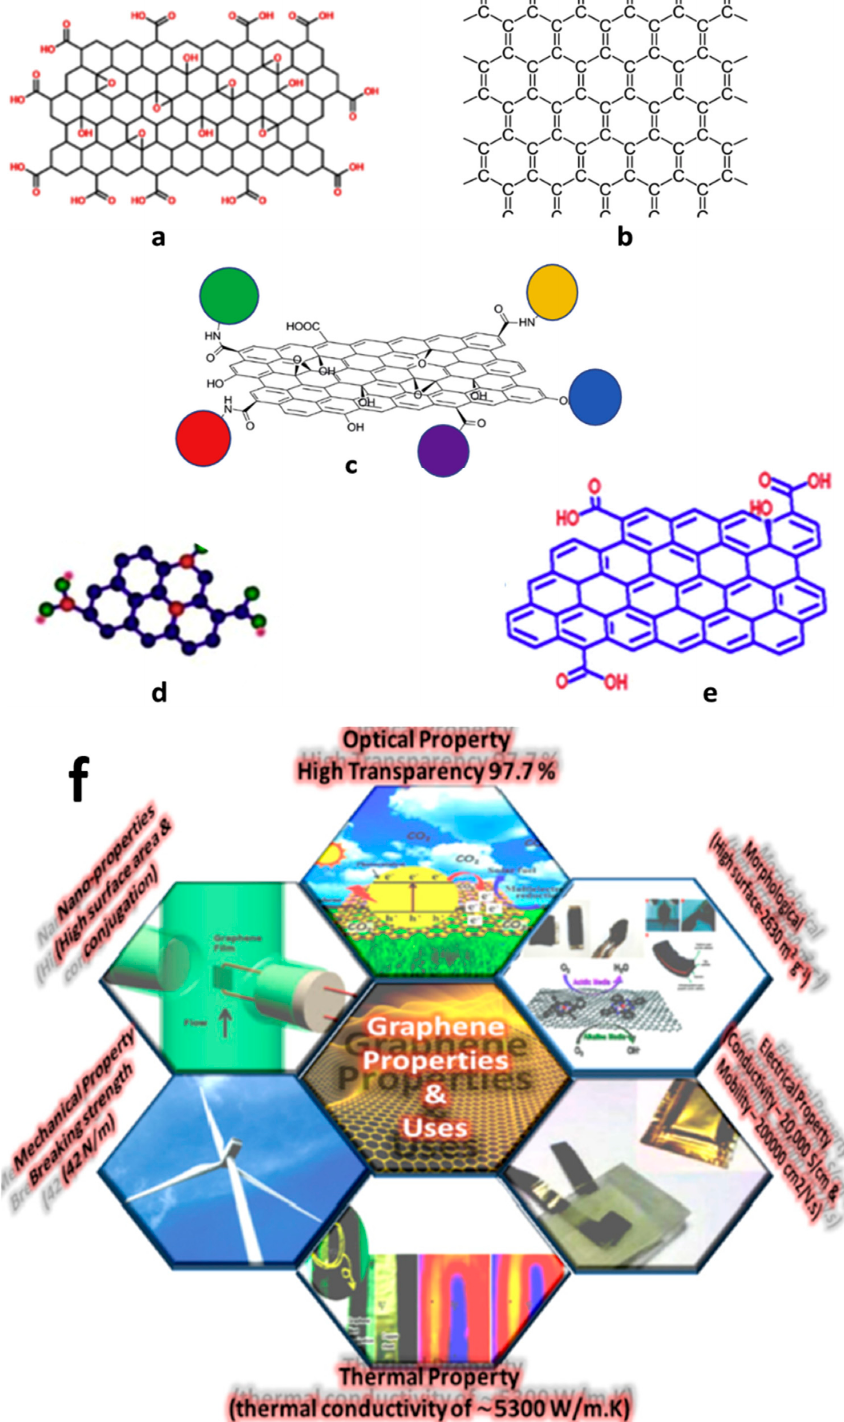
Figure 3. Some common forms of graphene: ( a ) graphene oxide, ( b ) pristine graphene, ( c ) functionalized graphene, ( d ) graphene quantum dot and ( e ) reduced graphene oxide. Reproduced with permission from Reference [46]. Licensed under a Creative Commons Attribution 3.0 International License (https://creativecommons.org/licenses/by/3.0/); ( f ) Different properties of graphene and its applications. Reproduced with permission from Reference [108]. Copyright © 2019, Elsevier.